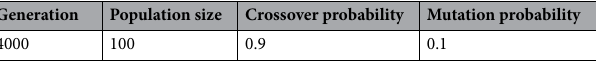
Table 2. Specific parameter values of NSGA-2.